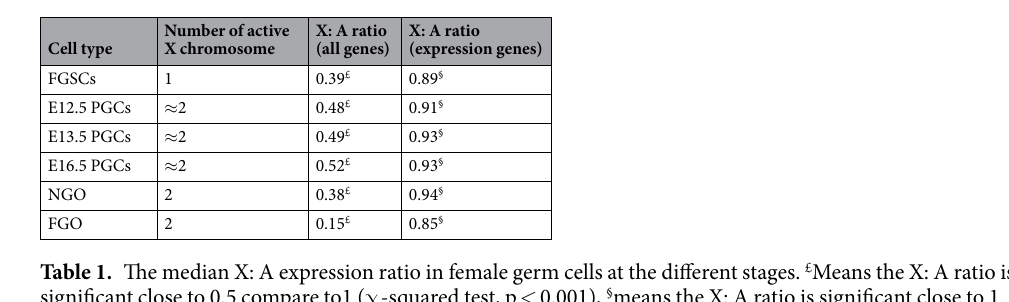
Figure 2. Comparisons of RNA-Seq gene expression levels between the X chromosome and autosomes in germ cell development. ( A ) X: A ratios of median expressions from germ cells when genes with no or very low expression are taken into consideration. The X: A ratio is significant closer to 0.5 compared to1 (Student’s t-test, p < 0.001). ( B ) For all types of germ cells, the X: A median expression ratios increased to close to 1 as no-/low- expression genes were gradually removed and remained stable after genes with FPKM ≤ 1 were removed. There were no differences between each types of germ cells. (P > 0.05, by Student’s t-test). ( C ) X: AA ratios of median expressions from germ cells when excluding no-/low-expression genes. There were no differences between each types of germ cells. (P > 0.05, by Student’s t-test) and the X: A ratio is significant closer to 1 compared to 0.5 (student’s t-test, p < 0.001). ( D ) Histograms of X-linked and autosomal expression distributions for male and female PGCs (mPGCs and fPGCs), FGSCs and NGO (Oocytes) (P > 0.05, by Kolmogorov-Smirnov test). The percentiles in all boxplots are 0.05, 0.25, 0.5, 0.75 and 0.95.